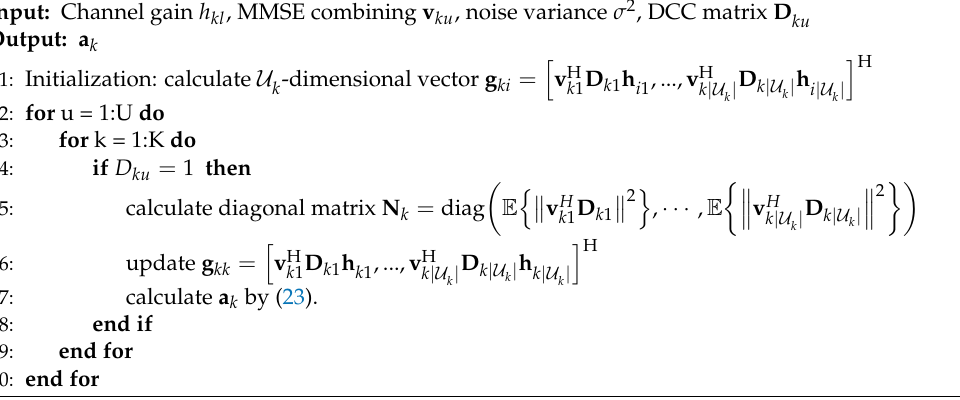
Algorithm 1 Optimization algorithm for Level